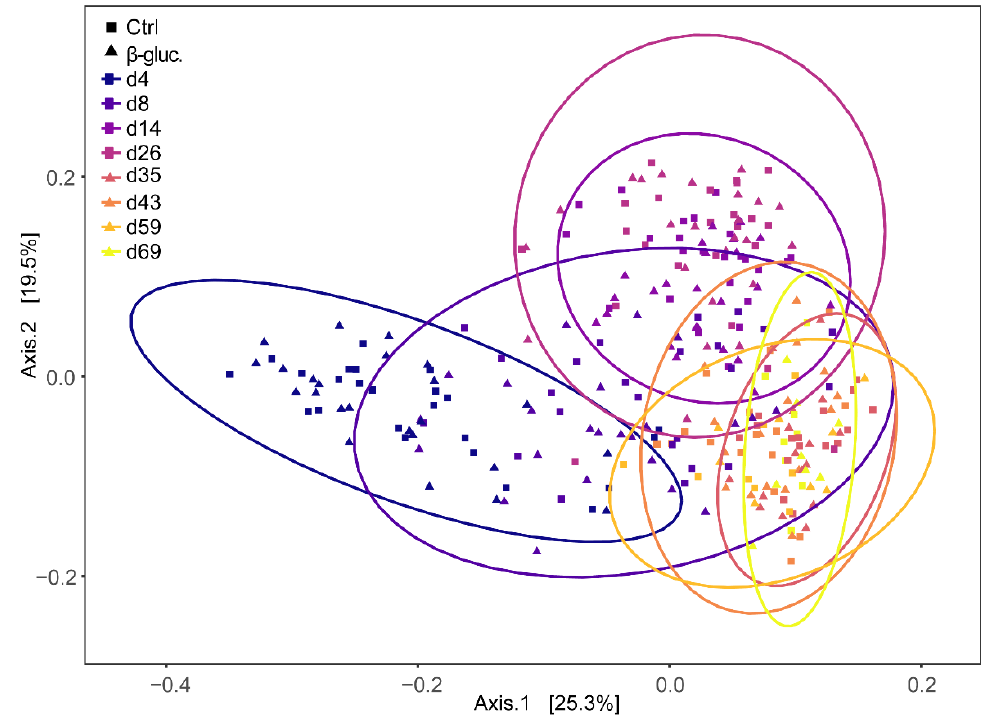
Figure 4. Principal Coordinates Analysis (PCoA) plot of beta-diversity based on weighted Unifrac dissimilarities in faecal samples over time (d4-69). Every dot represents a faecal sample from a single animal and samples are enveloped per time point. Control and β-glucan treated animals are represented by squares ( ■ ) and triangles ( ▲ ), respectively.